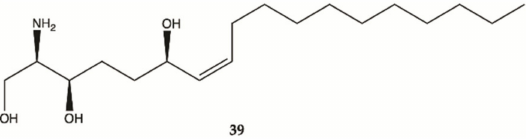
Figure 15. Sphingosine 39 isolated from a marine sponge Haliclona tubifera [54]. Overall, marine sponges from Brazilian, Hawaiian, Caribbean and South Pacific coasts were explored for their ability to produce secondary metabolites with anti-glioma